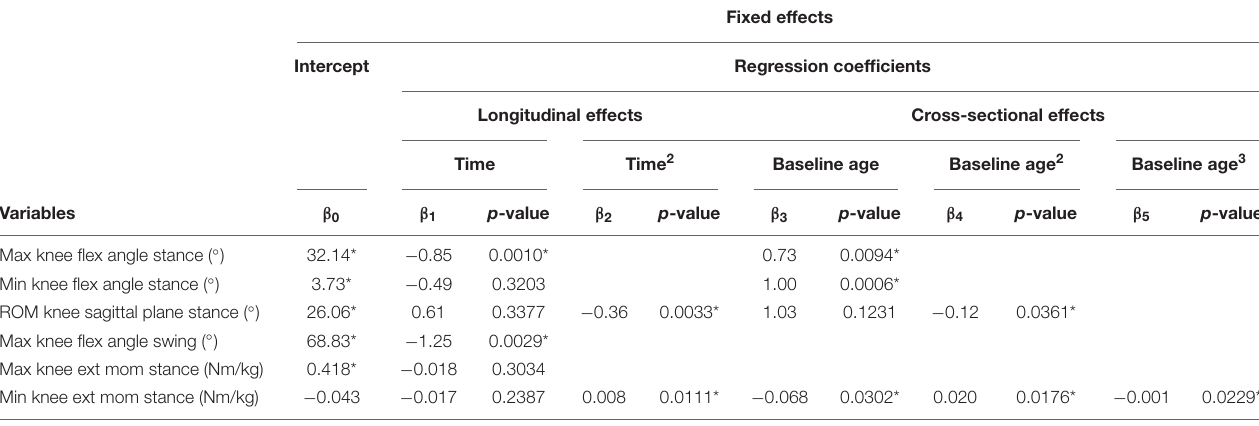
TABLE 6 | Results of linear mixed effect models with knee kinematics and kinetics as responses in children with